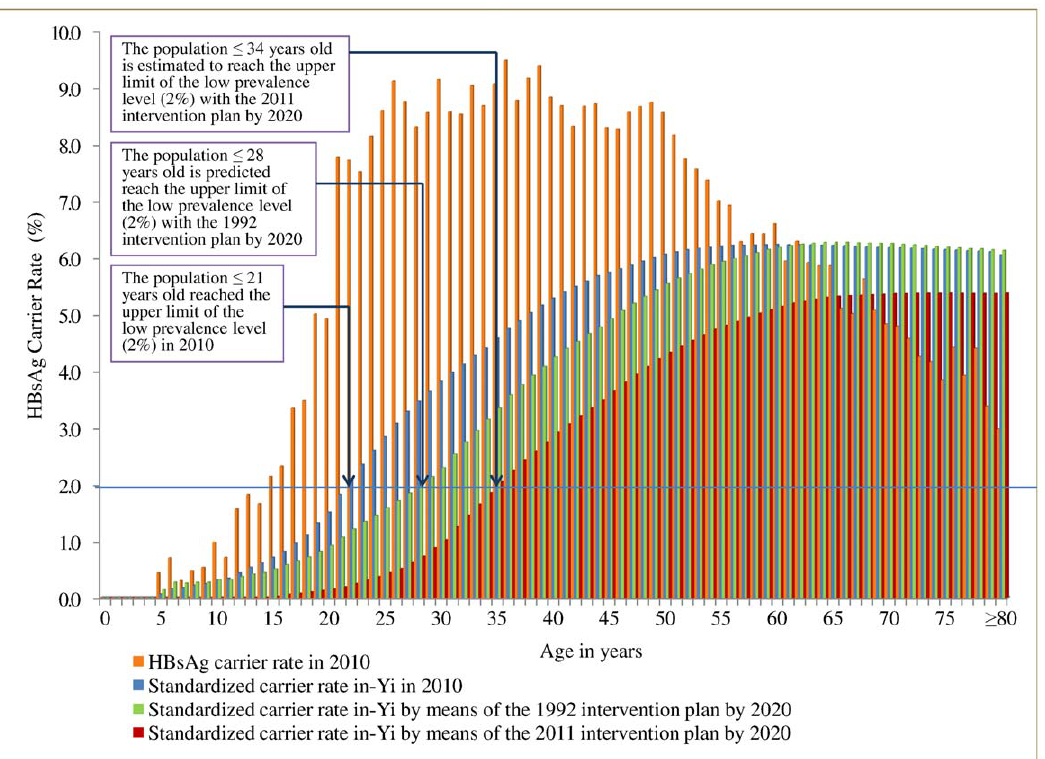
Figure 3. Comparison of predicted distribution of HBsAg carrier rate by age by the year 2020 under the 1992 and 2011Programs. The orange bar represents the real carrier rate by age, the blue bar the average cumulative carrier rate from zero to a specific age in 2010, the green bar the average cumulative carrier rate from zero to a specific age in 2020 under the 1992 Program, and the red bar the average cumulative carrier rate from zero to a specific age in 2020 with the 2011 Program. The line at 2% is the upper limit of the low prevalence level as defined by WHO.